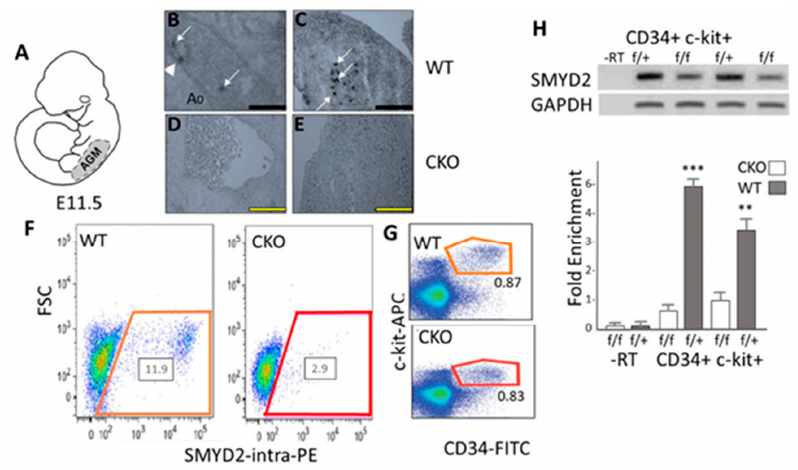
Figure 1. SMYD2 expression and its vav -Cre-mediated loss occurs within E11.5 aorta-gonad- mesonephroses (AGMs). ( A ) Cartoon of an embryonic (E) day 11.5-E12.5 mouse embryo showing location of AGM. ( B – E ) SMYD2-specific in situ hybridization on cryosections from E12.5 vav -Cre / Smyd2 F / WT (WT) ( B , C ) and conditional knockout (CKO) ( D , E ) and embryos. Sections were processed at the intersection of the aorta with the vitelline artery. The dorsal aorta (Ao) is noted. Arrows denote SMYD2-expressing cells in the lumen (arrow), attached to the Ao endothelium (arrowhead) as well as disseminated in the stomach (arrows). SMYD2 sense-strand mRNA probe showed no signal (not shown). Magnification 40 × . Representative data of 4 independent measurements. Scale bars: (A,B) = 50 µ m; (C,D) = 100 µ m. ( F ) Fluorescence-activated cell sorting (FACS) analysis of SMYD2 WT (left) and CKO (right) AGM explants stained intracellularly with anti-SMYD2 antibody. Representative data ( n = 3) shown as percentage of SMYD2 + cells. ( G ) FACS plots of SMYD2 WT (top) and CKO (bottom) AGM explants demonstrate SMYD2 expression in c-Kit + CD34 + hematopoietic populations. Representative data of n = 3 independent experiments. ( H ) RT-PCR (upper panel) and Q-RTPCR (lower panel) analysis of c-Kit + CD34 + E12.5 WT (f /+ ) and CKO (f / f) RNA confirm significant vav -Cre knockdown in CKOs. Shown are the averages of 3 independent experiments. ** p ≤ 0.01; *** p ≤ 0.001. Br. Relat. Politics Ubiquitous fusion Cybertherapy Cult. Migr. Cells that populate AGMs, defined as hemogenic endothelium, are distinct from HSC and progenitor cells, as well as nonhemogenic endothelial cells [20–22]. To resolve where SMYD2 expression arises, AGM tissue from E12.5 CKO and WT embryos was harvested from pregnant females, digested to single cell suspensions, and analyzed with fluorescently conjugated Abs (detailed in supplementary materials). Flow cytometry was employed to determine the number and